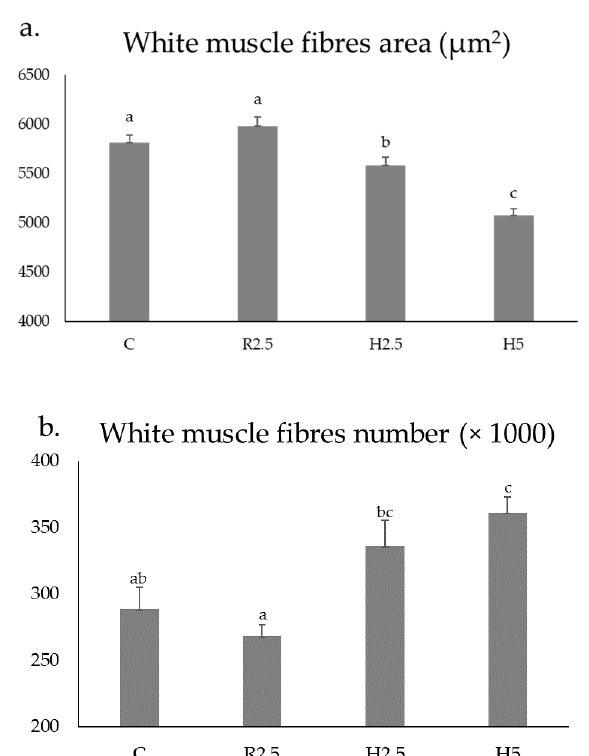
Figure 2. Mean ± SEM values of the area of the white muscle fibres ( a ) and number of the white muscle fibres ( b ) of 1.6-year-old adult specimens of Sparus aurata from the C, R2.5, H2.5, and H5 groups. Different lower-case letters indicate significant differences ( p < 0.05) between groups for each parameter. Mean values were obtained from nine specimens per group.